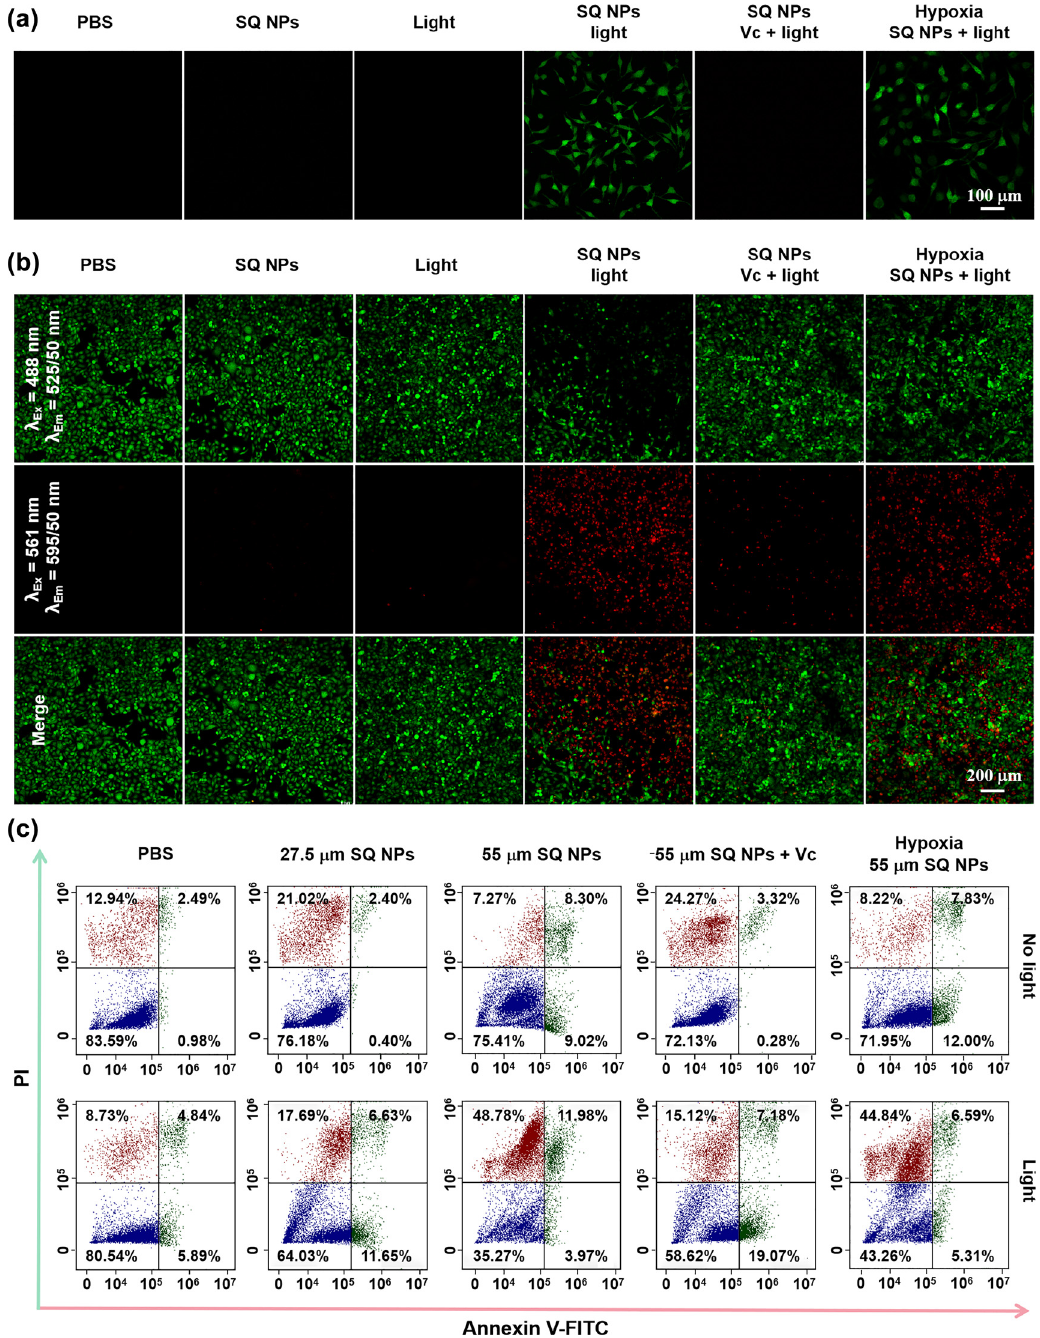
Figure 3: ROS production and PDT capacity of SQ NPs in vitro samples. (a) ROS production capacity of SQ NPs in SH-SY5Y cells treated with (I) PBS, (II) SQ NPs, (III) Light, (IV) SQ NPs + Light, (V) SQ NPs + Vc + Light and (VI) hypoxia SQ NPs + Light. (b) PDT capacity of SQ NPs on SH-SY5Y with treatments: (I) PBS, (II) SQ NPs, (III) Light, (IV) SQ NPs + Light, (V) SQ NPs + Vc + Light and (VI) hypoxia SQ NPs + Light. (c) Apoptosis analysis of SH-SY5Y cells with various treatments. (Green channel: 500–550 nm, excited at 488 nm; red channel: 570–620 nm, excited at 561